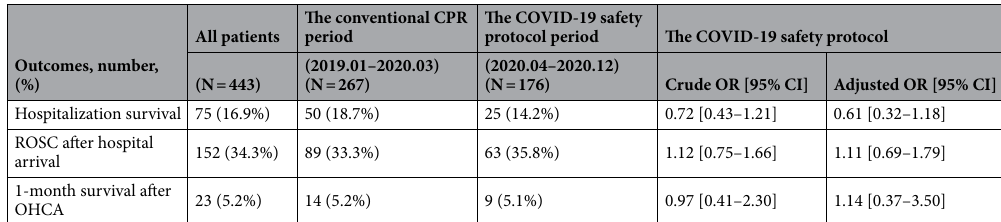
Table 2. The survival outcomes and multivariable logistic regression analysis for outcomes during the COVID-19 safety protocol period. Values are number (percentage). Confounding variables included resuscitation under the COVID-19 safety protocol, age, presence of witness, presence of bystander CPR (cardiopulmonary resuscitation), initial cardiac rhythm at the scene, call–hospital interval, and the first documented cardiac rhythm at hospital arrival. CI confidence interval, COVID-19 coronavirus 2019, OHCA out-of-hospital cardiac arrest, OR odds ratio, ROSC return of spontaneous circulation.